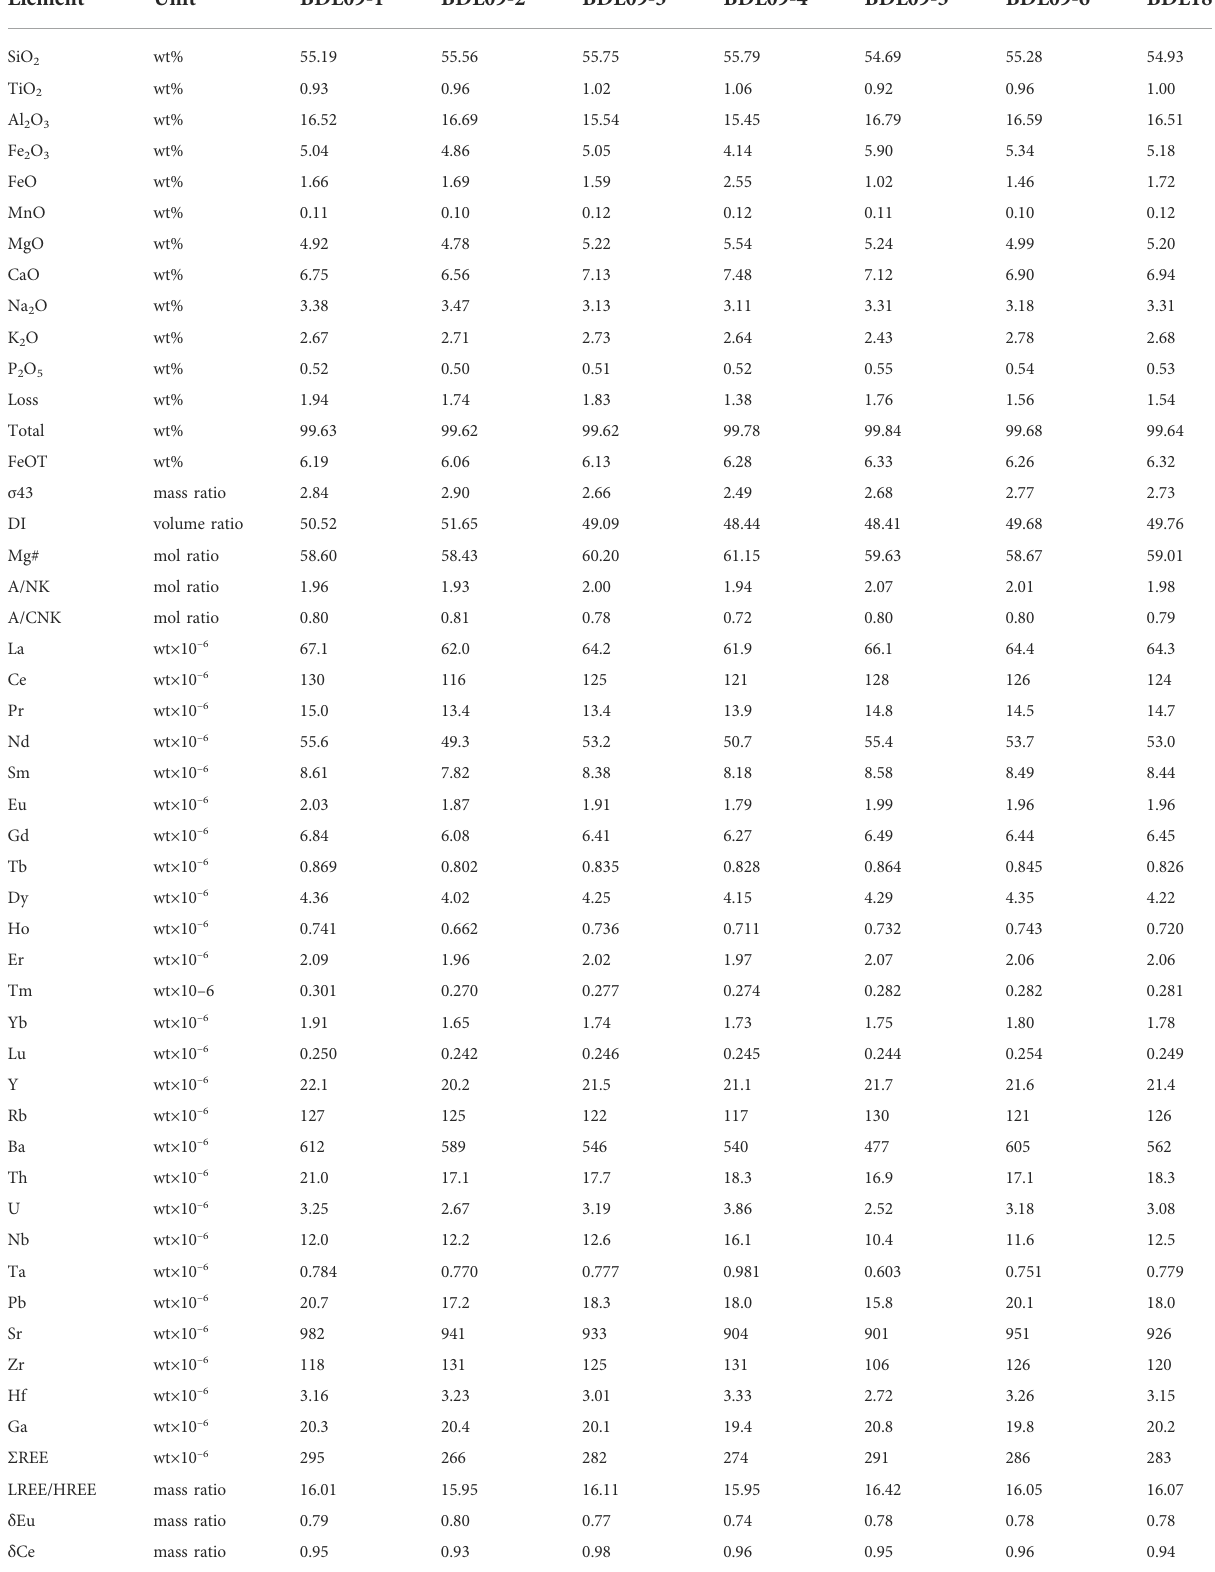
TABLE 1 Major element compositions of monzodiorite in the Budongla gold